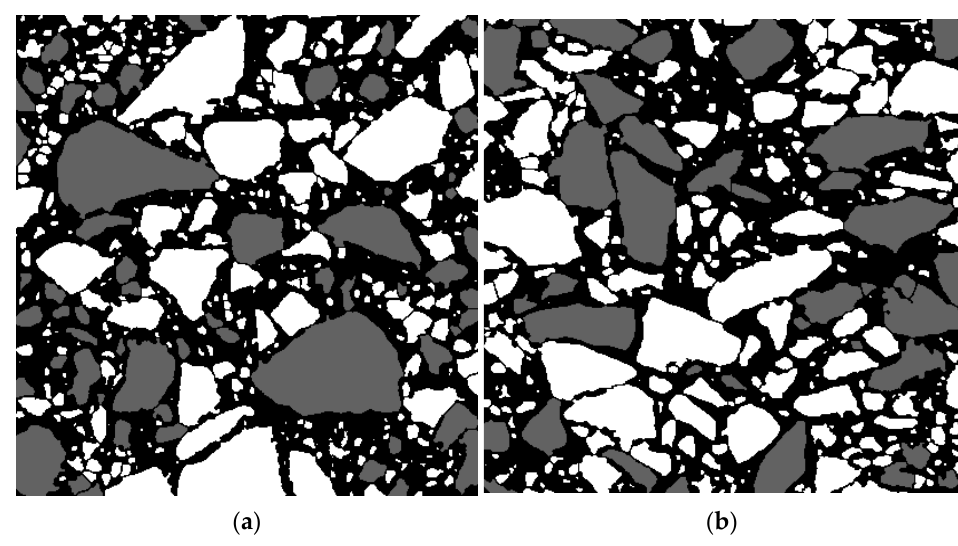
Figure 8. Grey images: ( a ) scan in xy plane; ( b ) scan in xz plane.